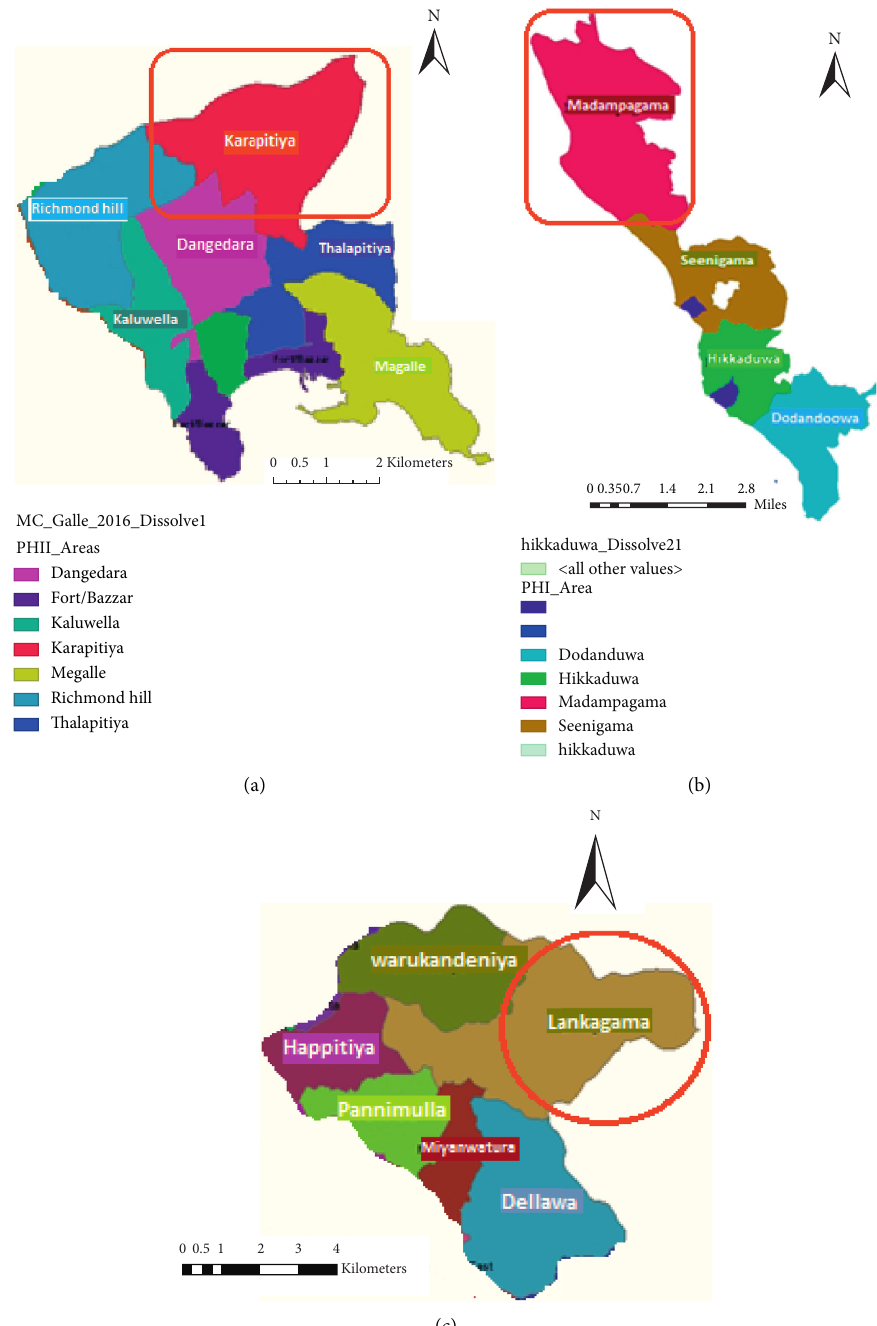
Figure 1: The selected sites in the Galle district, Sri Lanka. (a) Urban-Karapitiya. (b) Semiurban-Madampagama. (c)